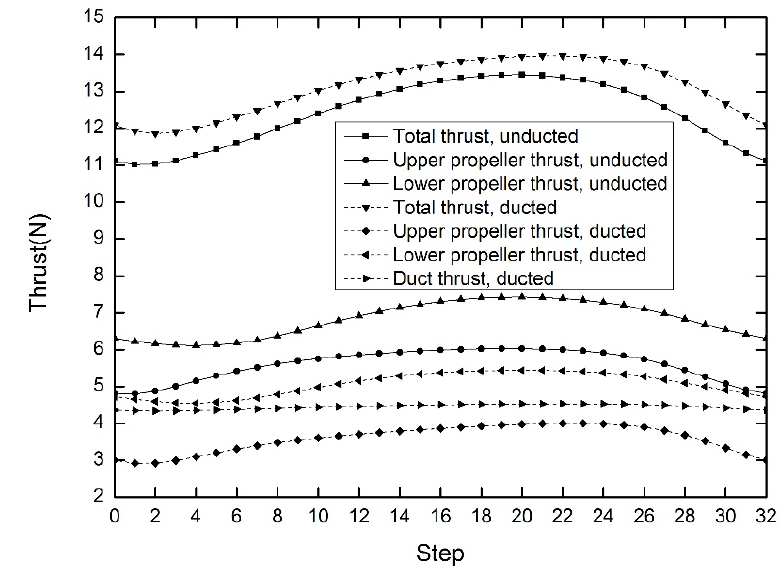
Figure 15. Thrust of unducted propellers and ducted fan UAV in one cycle.